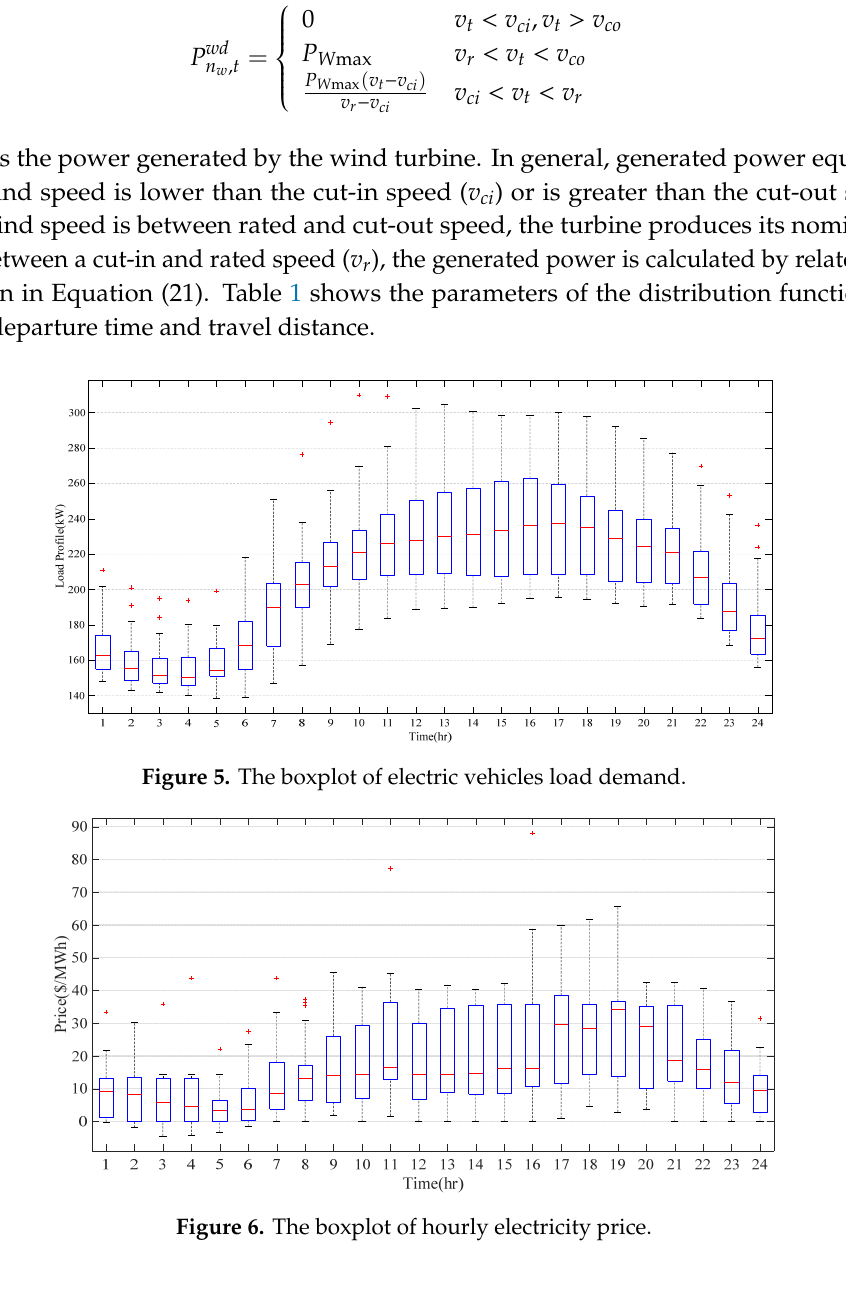
Figure 7. The boxplot of hourly wind speed. 2.1.4. Optimization Procedure A mixed-integer non-linear problem (MINLP) is presented to optimize the cost function by considering the PEVs batteries’ SOC at the departure time as the optimization constraints. MINLP is considered because of the complexity of the economic dispatch, power loss considerations and network constraints compounded with the charging and discharging of PEVs’ batteries. The main goal is to minimize the Equation (1) by considering the other mentioned constraints such as SOC values. In the optimization procedure, the maximum value of the PEV’s SOC is not considered as a constraint for the problem formulation. The minimum value of batteries’ SOC is employed as a constraint, so the operator can charge the batteries as much as possible if this procedure is beneficial (i.e., depends on the electricity price and power system load). For solving the MINLP problem, General Algebraic Modelling System (GAMS) software has been used [27]. The “Conopt-4” solver is employed which has the capability to solve the convex nonlinear problem. 3. Results For the numerical study, a 21-node sample distribution network has been employed which is 13.8 Kv and has 20 feeder section which is shown in Figure 8. In this sample, six wind turbines which are able to produce 500 kVA are set up in buses 14, 15, and 18 to 21. The network characteristics and constraints such as voltage deviation and HV/MV substation capacity are derived from [16]. The load demand, electricity price, and wind speed data are simulated by the Monte-Carlo simulation. The normal distribution function for the load demand and electricity price and the Weibull distribution